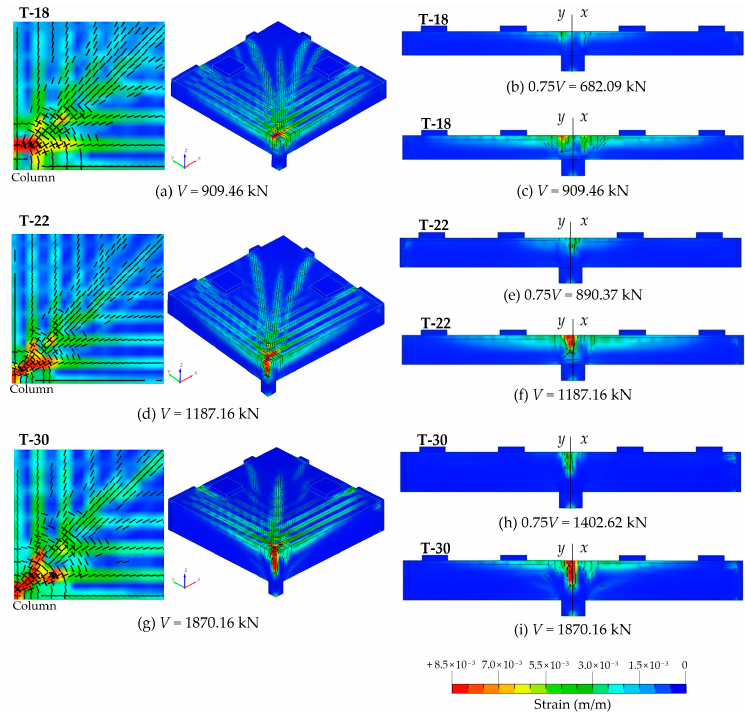
Figure 16. Cracking pattern of Series T models.